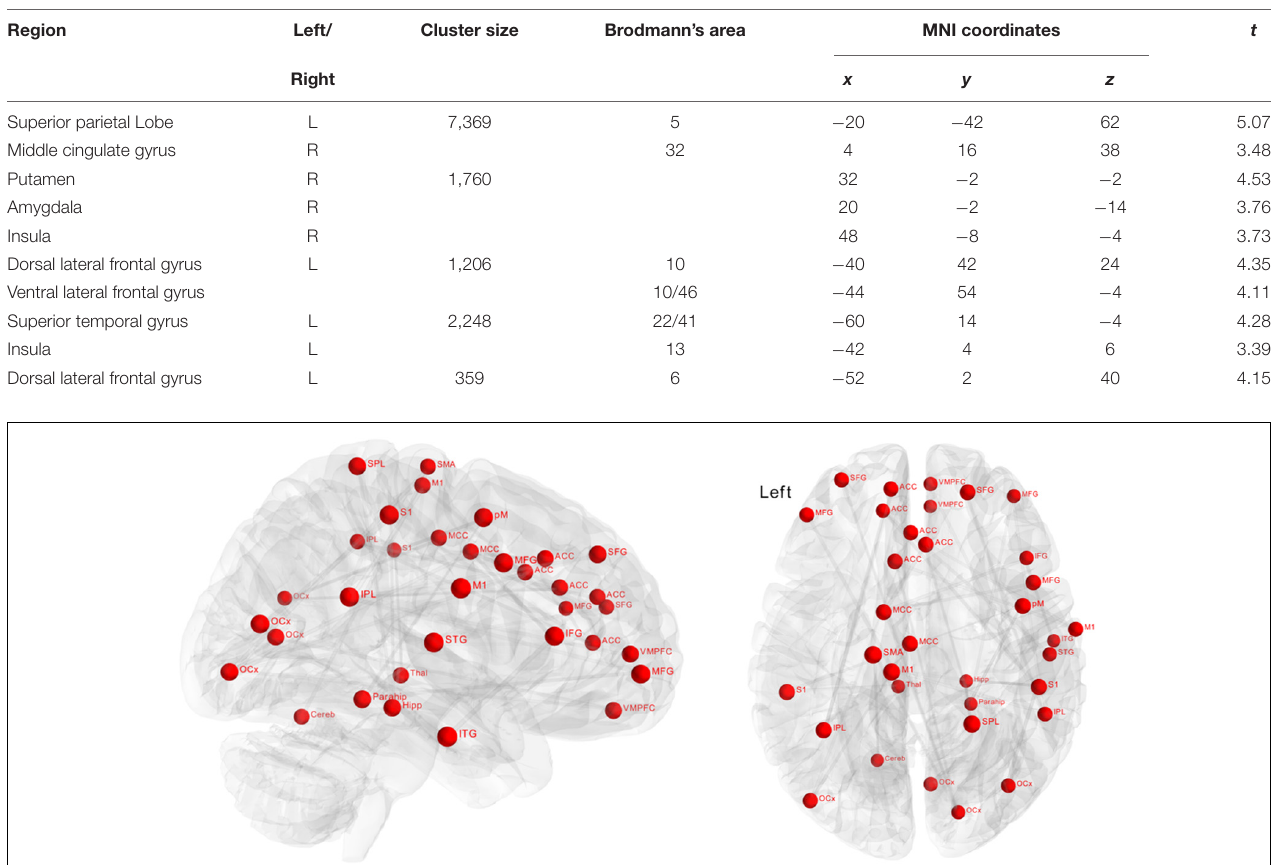
FIGURE 3 | Effect of biofeedback on functional connectivity matrices using network-based statistics (NBS). The graph shows nodes with significantly ( p = 0.048) higher connectivity after biofeedback intervention. These connections formed a single connected network with 34 nodes and 33